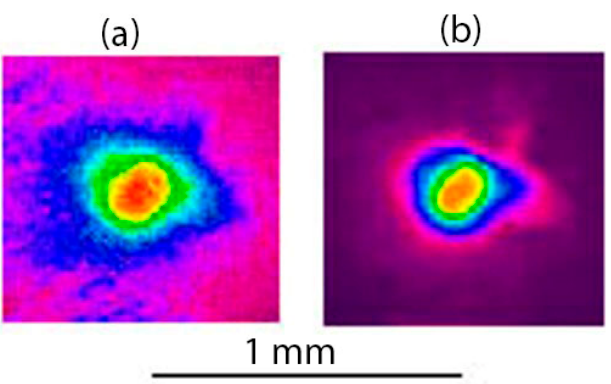
Figure 14. Distribution of laser radiation at the outlet of the channel of 23 mm length at different pulse energies ( a ) 110 and ( b ) 11 mJ.